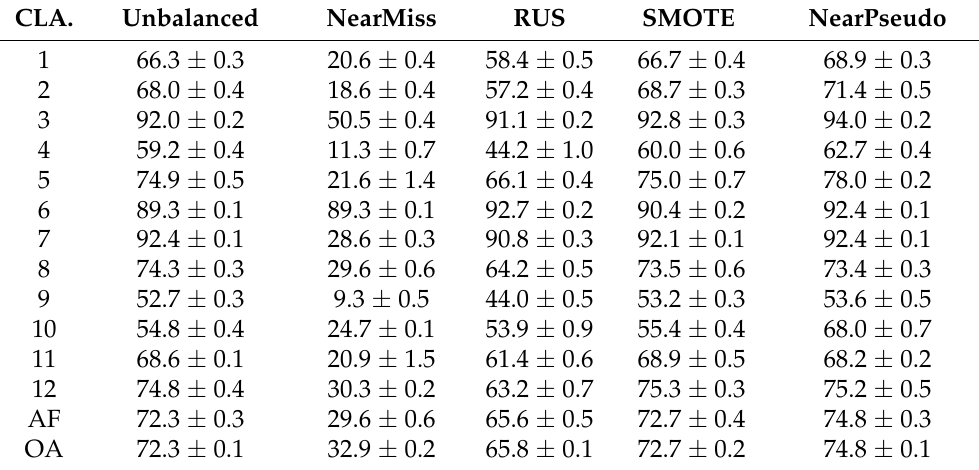
Table 2. Classification accuracy (%) of different solutions on sub-training data T1 . CLA.